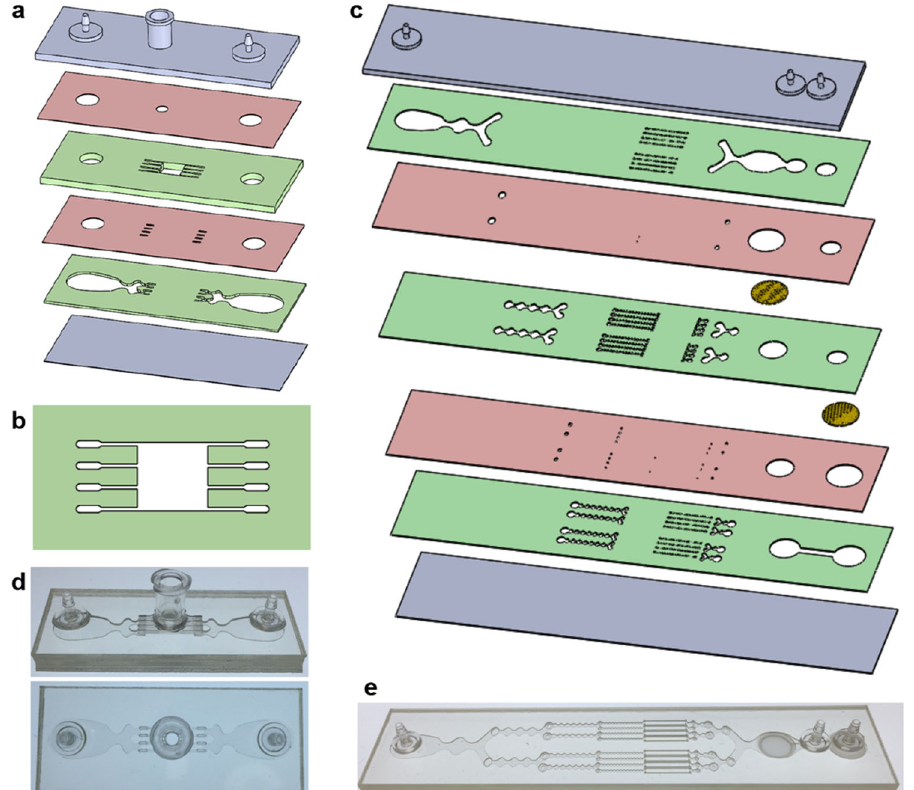
Fig. 1 Micro fl uidic tissue processing platform. a Schematic of the minced tissue digestion device. Design includes six total layers, including two fl uidic layers (green), 2 via layers (red), and the top and bottom end caps (gray). Tissue is loaded through the luer port and into the tissue chamber. b Schematic of the tissue chamber. Fluidic channels direct hydrodynamic shear forces and proteolytic enzymes, while also retaining minced tissue pieces in the chamber. c Schematic of the integrated dissociation/ fi lter device. Tissue fragments and cell aggregates from the digestion device will be further broken down by hydrodynamic shear forces and nylon mesh fi lters. d Pictures of the fabricated minced digestion device. e Picture of the fabricated dissociation/ fi lter